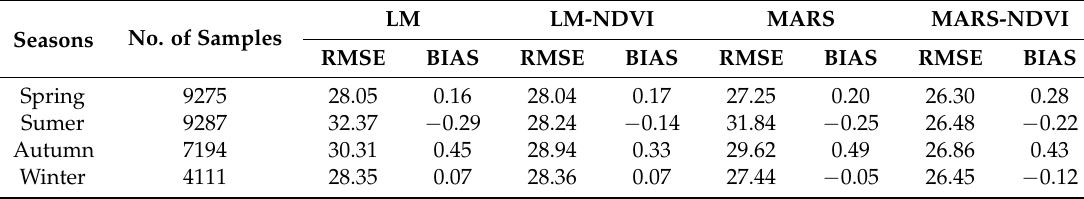
Table 2. Summary of statistics of the four developed models for spring, summer, autumn, and winter. Linear model (LM); normalized difference vegetation index (NDVI); multivariate adaptive regression spline (MARS); RMSE; BIAS.